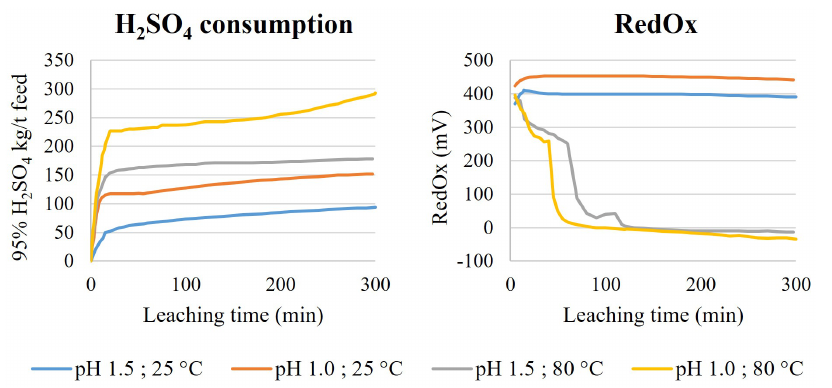
Figure 1. H 2 SO 4 consumption (expressed as kg 95% H 2 SO 4 per one ton of feed material) and RedOx in screening tests.